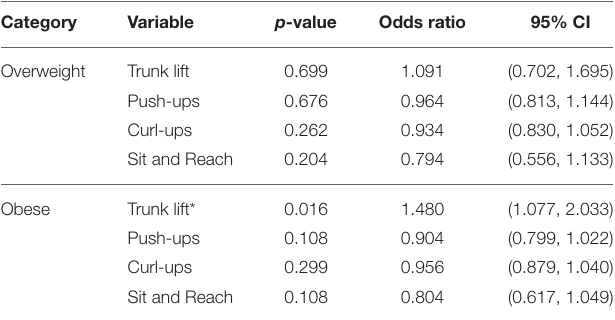
TABLE 6A | Associations between musculoskeletal fitness and weight status in fourth grade (reference group: healthy weight).